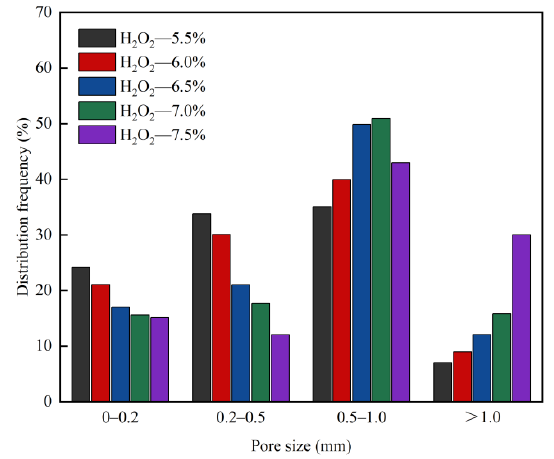
Figure 6. Effect of H 2 O 2 content on porosity of foam concrete.